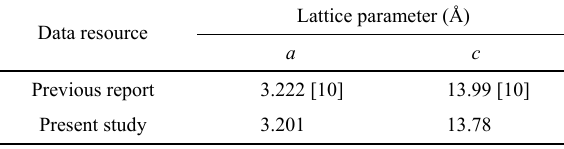
Table 2 Lattice parameters of Ti 2 PbC reported in the literature and measured from XRD results in this Lattice parameter (Å) Data resource